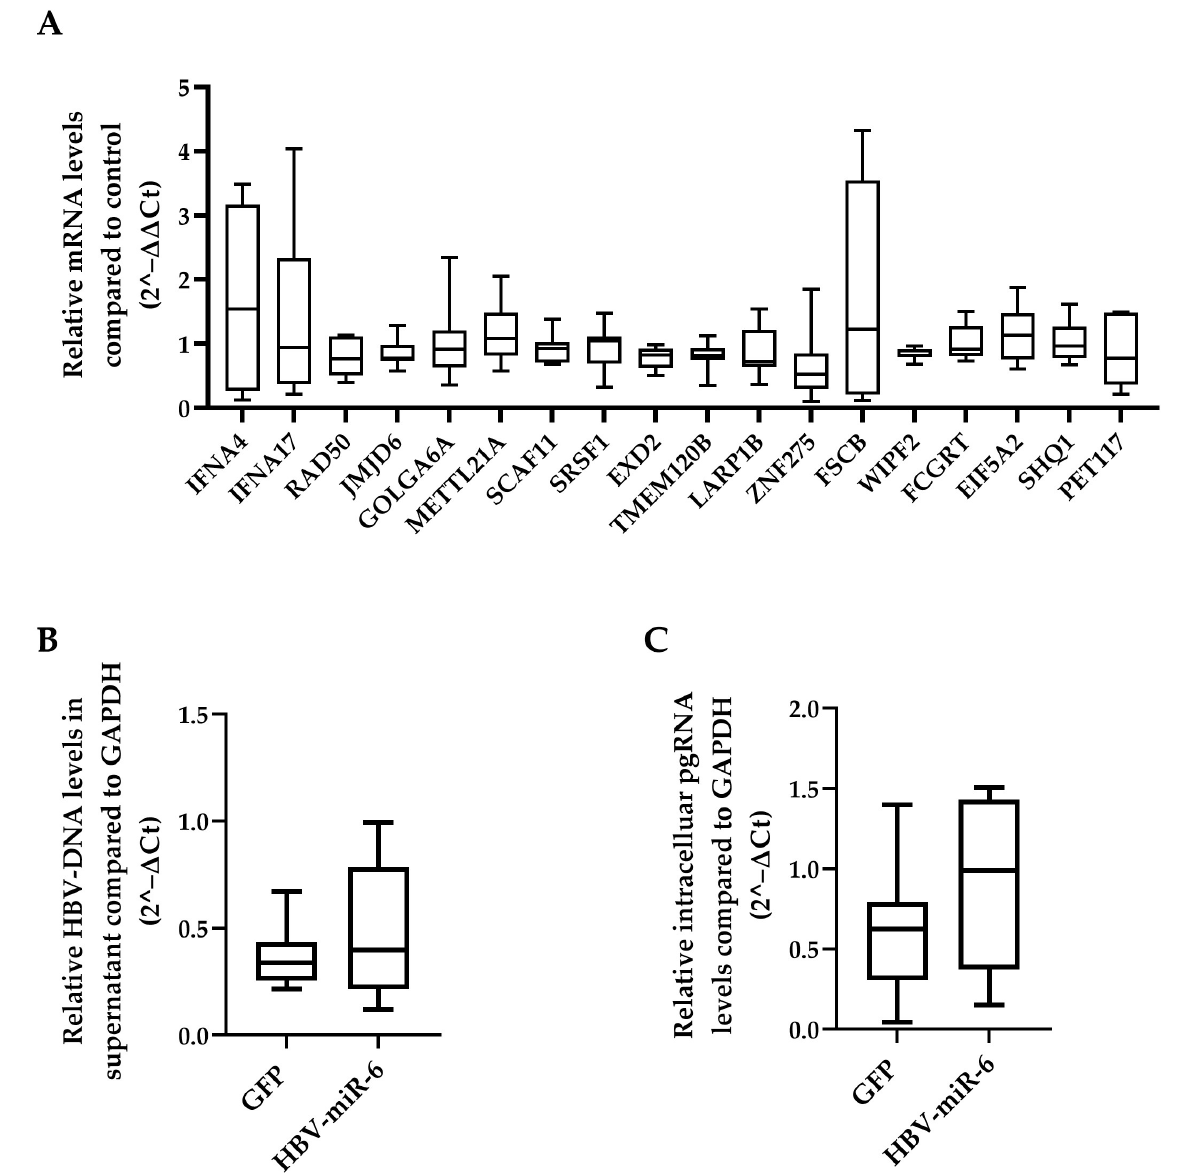
Figure 4. Effect of HBV-miR-6 on the expression of predicted host targets and HBV replication. ( A ) HepG2 cells were transduced with a lentiviral vector expressing HBV-miR-6 or GFP. The expression levels of potential HBV-miR-6 target genes were measured using qPCR at day 6 after transduction. HepG2.2.15 cells were transduced using a lentiviral expressing HBV-miR-6 or GFP. HBV replication was determined at day 6 after transduction using qPCR detecting intracellular pgRNA ( B ) and encapsidated HBV-DNA ( C ) in culture supernatant. Relative gene expression levels were normalized to GFP control using the 2ˆ − ∆∆ Ct method. Relative expression levels of pgRNA and HBV-DNA were normalized to GAPDH expression using the 2ˆ − ∆ Ct method and groups were compared using a Mann–Whitney U test. Data are presented as a boxplot and whiskers; graphs represent averages of results from three independent